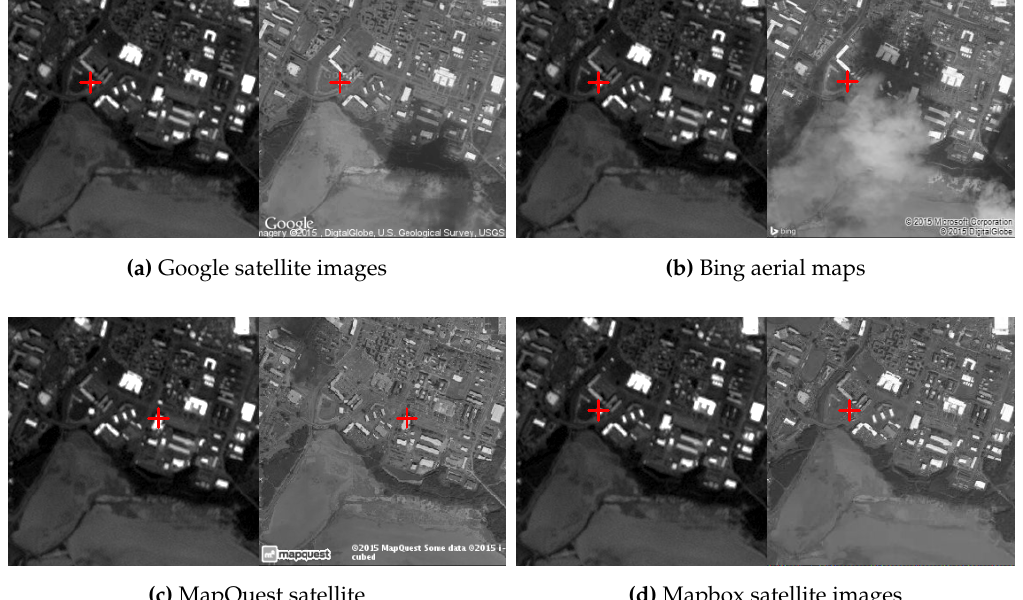
Figure 6. Example of online matching, and the matched points are marked by cross. ( a ) to ( d ) are matching results using Google satellite images, Bing aerial maps, MapQuest satellite maps and Mapbox satellite images, respectively. In each figure, the left is the RapidEye image tile, while the right is the online aerial map.